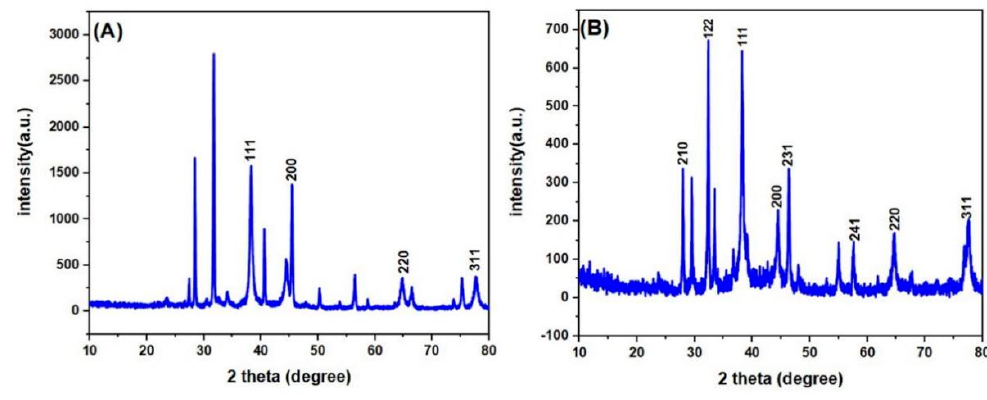
Figure 2. XRD plot of ( A ) AuNPs and ( B ) AgNPs. Table 1. Calculated crystallite sizes and average crystallite sizes for all assigned peaks obtained from XRD analysis of Au and AgNPs. Angle (2 θ ) Crystal